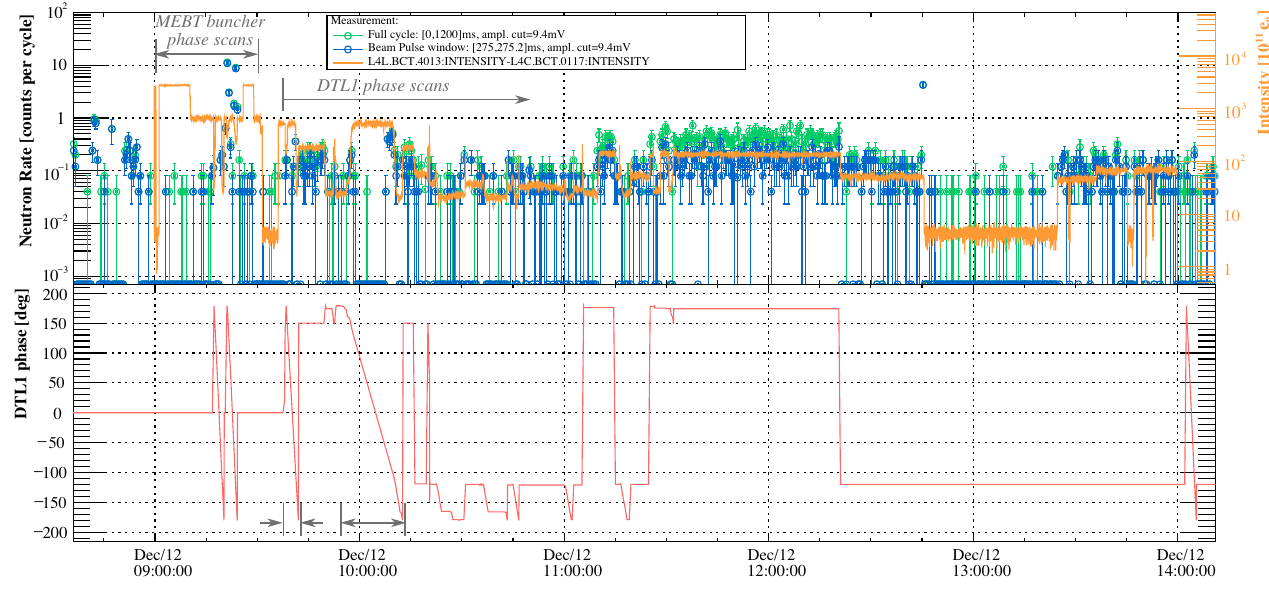
FIG. 19. Example of estimated neutron rates (top) during LINAC4 commissioning activities focused on phase scans of cavities upstream of the nBLM detector. See text for